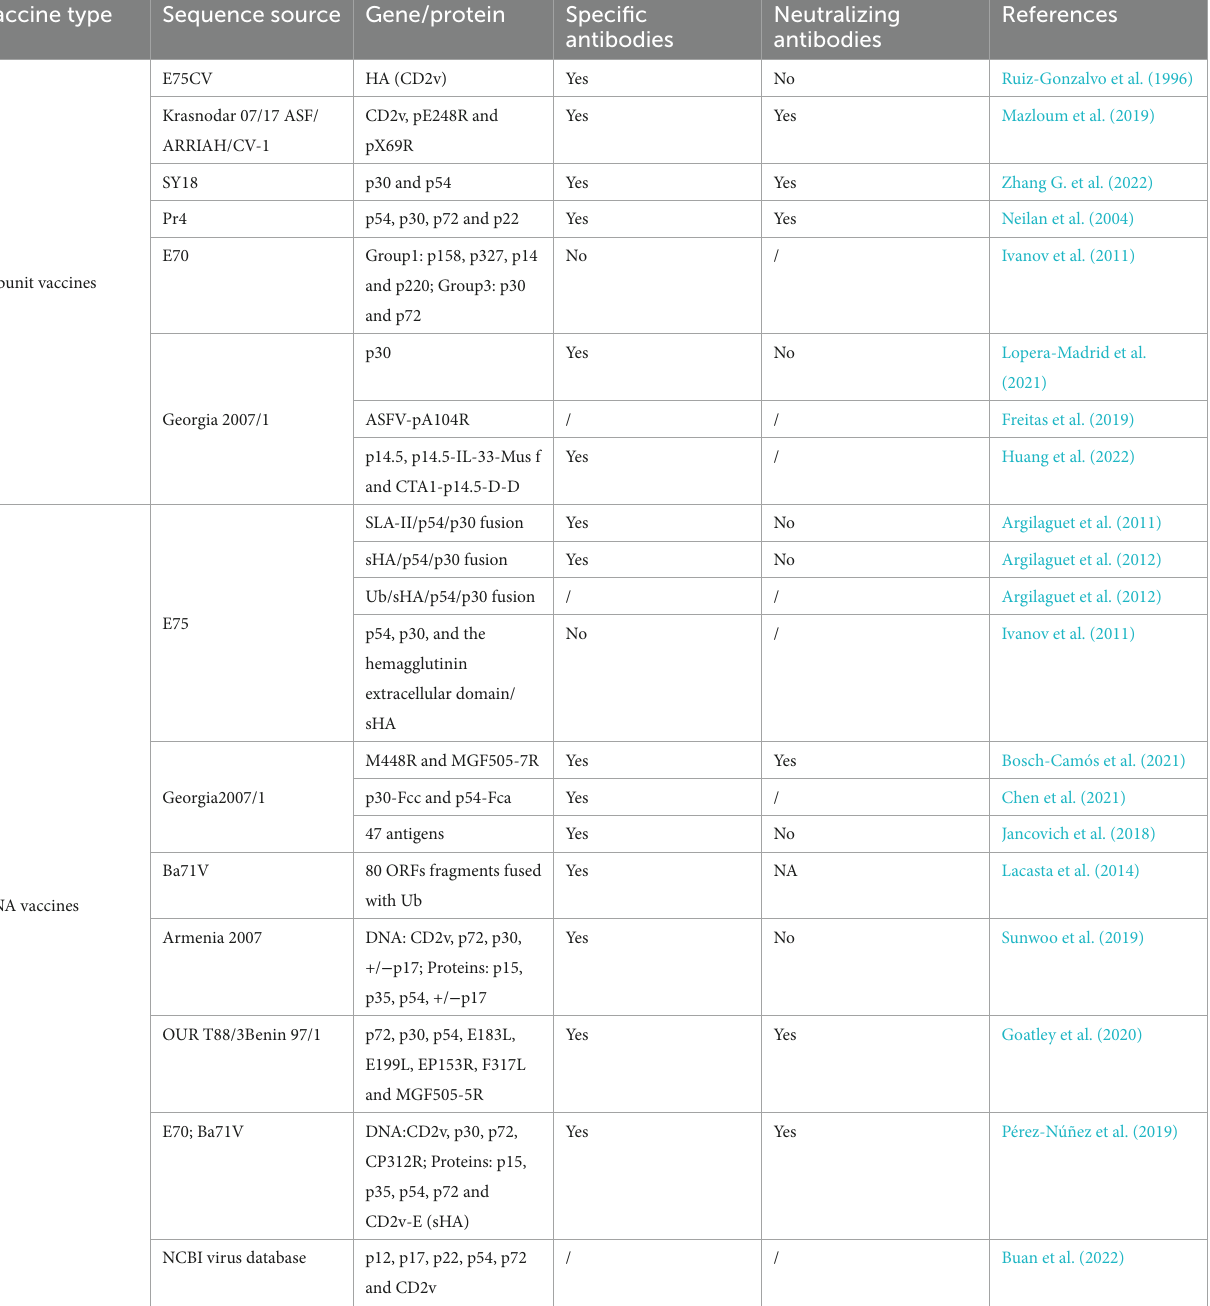
TABLE 4 ASF subunit and DNA